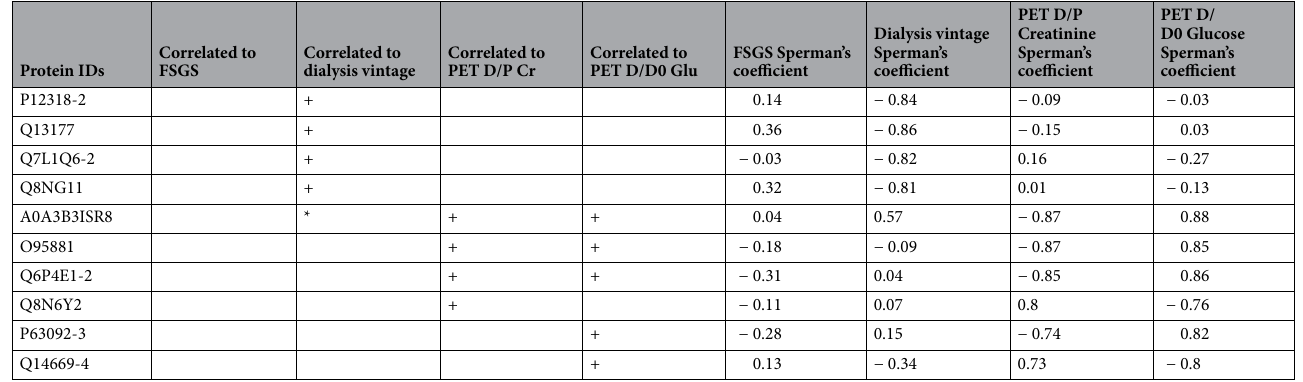
Supplemental Figure S3, S4.